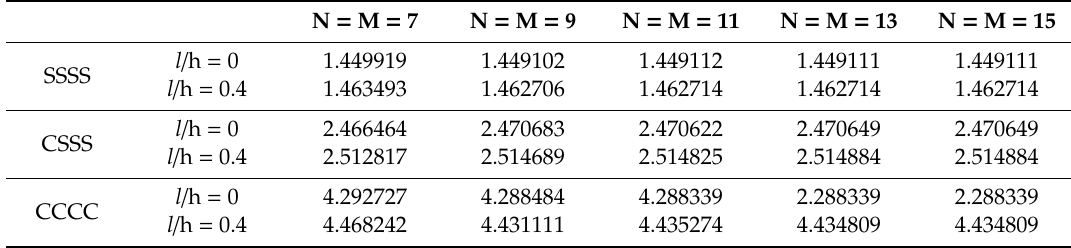
Table 2. The dimensionless critical temperature of the GPLRC panel for various boundary conditions, numbers of grid points and length scale parameters when a / b = 0.5, h = a / 7, GPL-UD, R1 = R2 = a, g GPL = 0.3%.